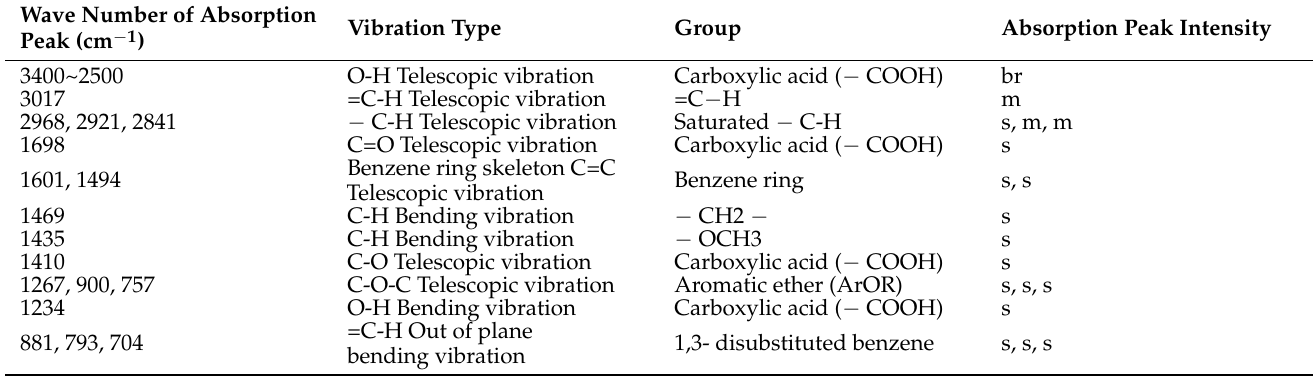
Table 2. The element composition of toxin compound by